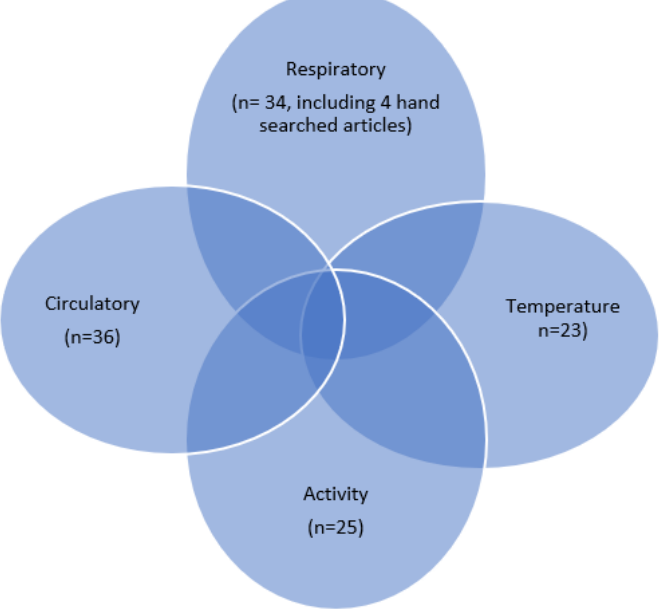
Figure 2. Diagram of systematic selection by parameters.